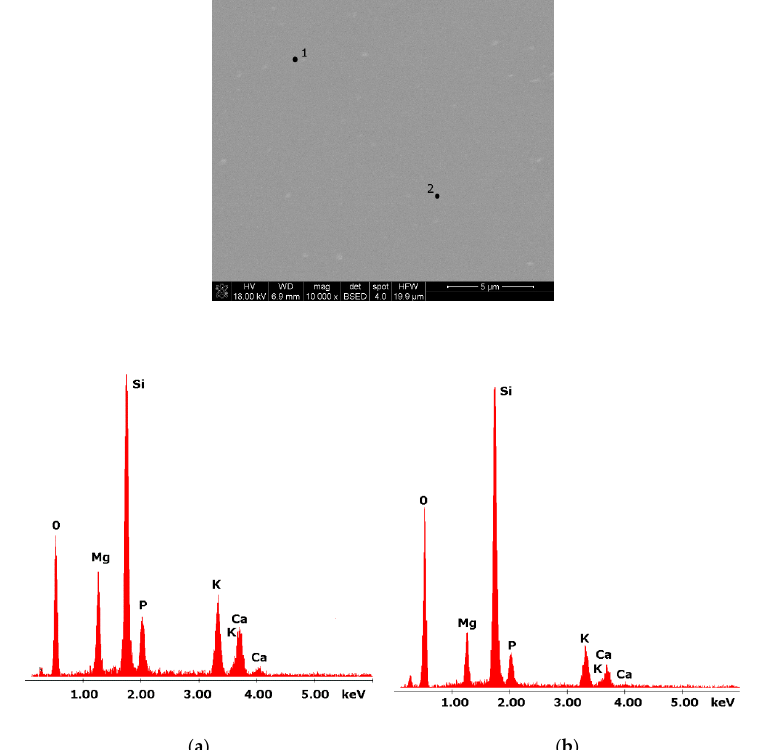
Figure 1. SEM microphotograph of 4B glass. (10,000×): ( a ) EDS analysis of 4B glass (p.1); ( b ) EDS analysis of 4B glass (p.2).